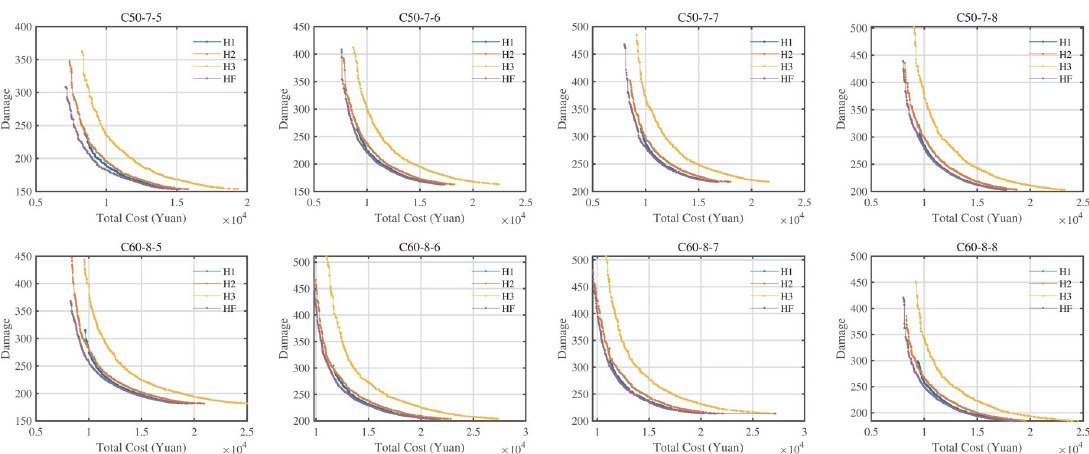
Fig 11. Pareto fronts of four variants of fleet composition.